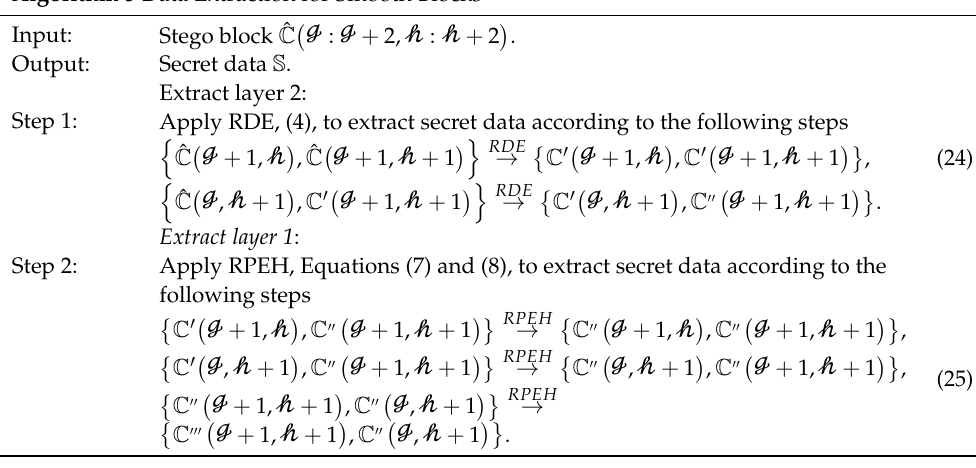
Algorithm 5 Data Extraction for Smooth Blocks